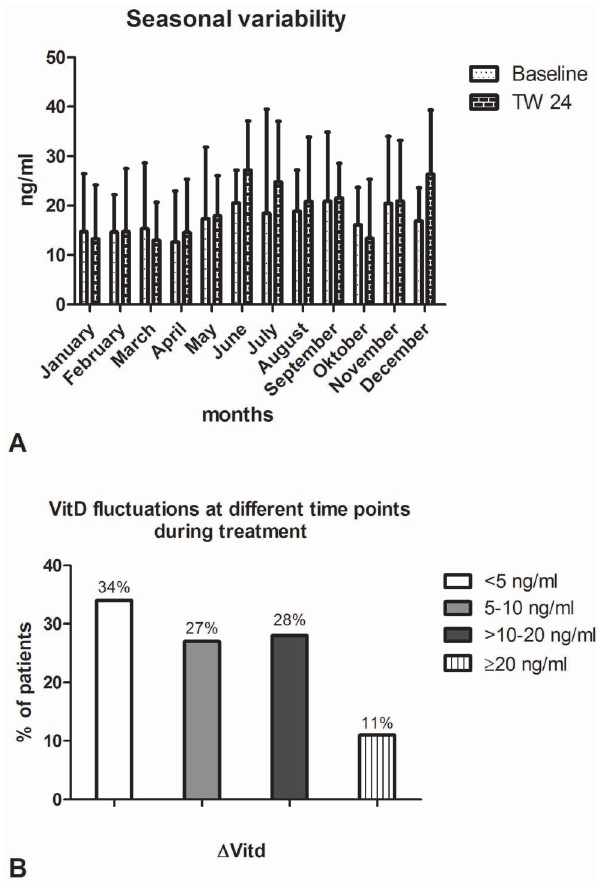
Figure 1. VitD concentrations vary dependent on the month of sample obtainment (1A), whereas fluctuations between base- line-VitD and TW24-VitD-values ( D Vitd) are observed as well